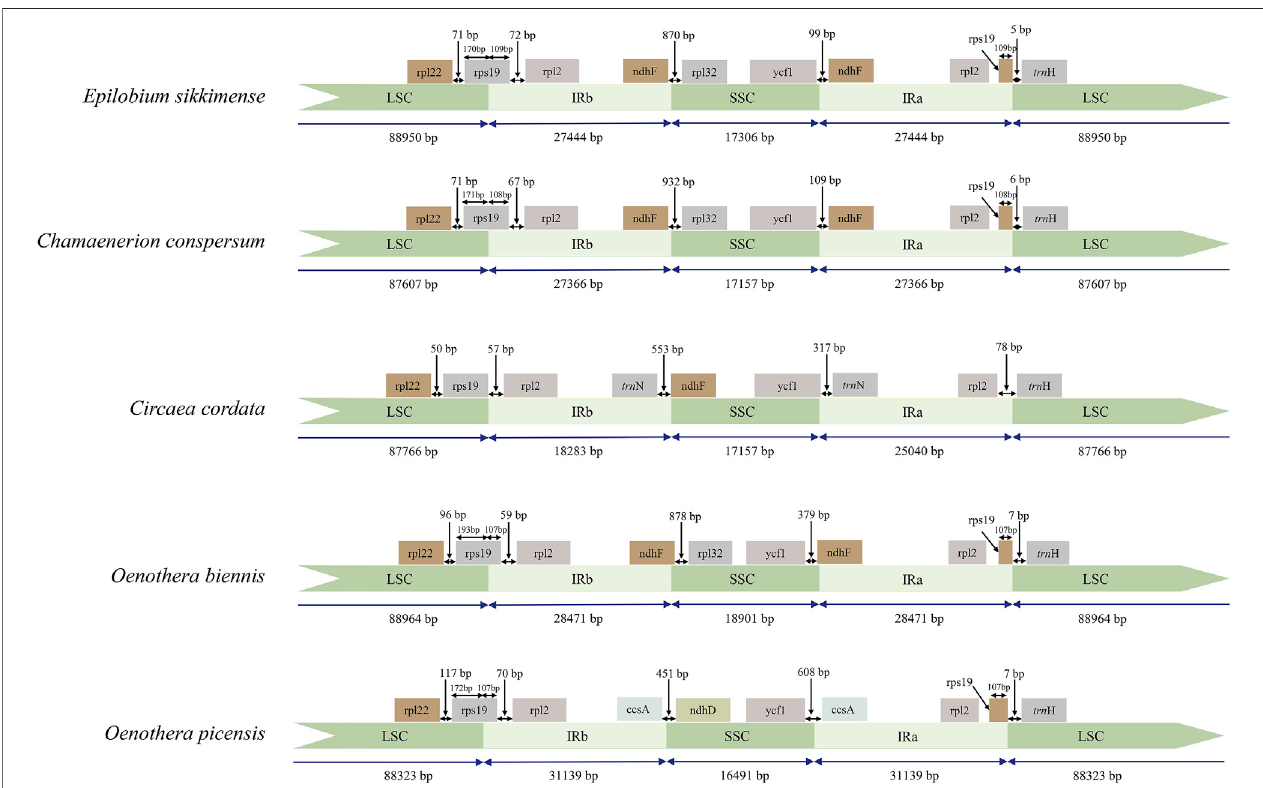
FIGURE 3 | Comparison of the LSC, IR, and SSC boundary regions of representative samples the three newly sequenced genera of Onagraceae and Oenothera samples. IR: inverted repeats; LSC: large single copy; SSC: small single copy.